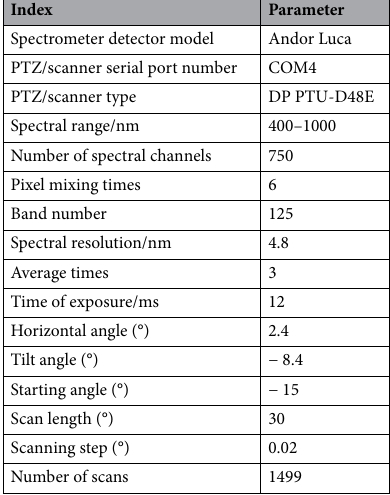
Table 2. Technical parameters of hyperspectral